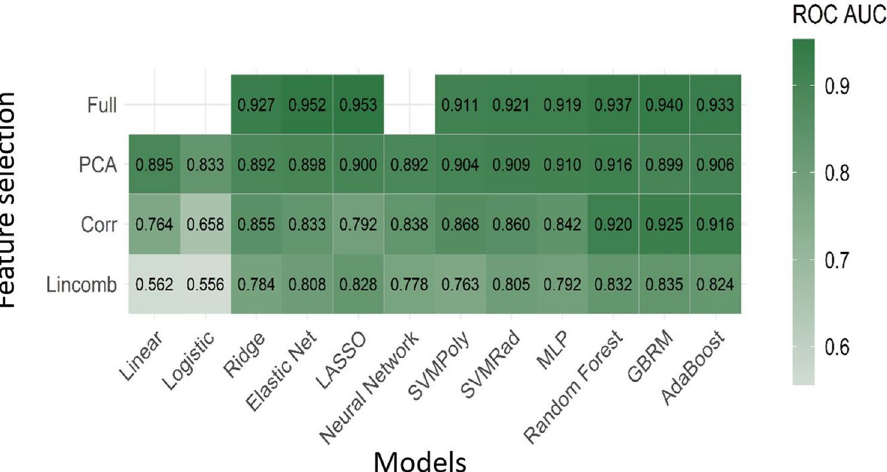
Figure 1. Diagnostic performance using multiparametric MRI. Mean cross-validated ROC AUC for all 45 machine learning and feature reduction combinations using all sequences.